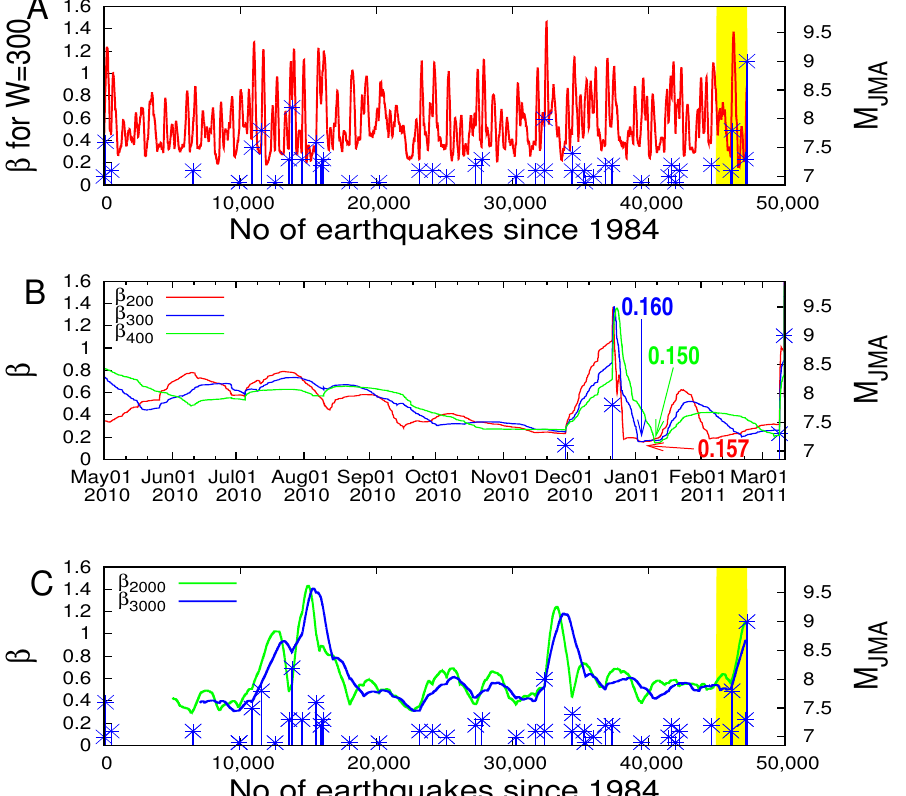
Figure 4. Plot of the variability β of κ 1 (left scale) together with all M JMA ≥ 6.9 EQs (blue asterisks, M JMA in the right scale). ( A ) Versus EQ number when a natural time window comprising W = 300 events is moving through the JMA catalog from 1984 until the M 9 Tohoku EQ occurrence. ( B ) Versus the conventional time during the period of the last 10 months (depicted by yellow in ( A )). Red for W = 200, blue for W = 300 and green for W = 400. Every tick corresponds to 10 days in the horizontal scale. ( C ) Variability β for natural time window W = 2000 (green) and W = 3000 (blue). Taken from Ref.